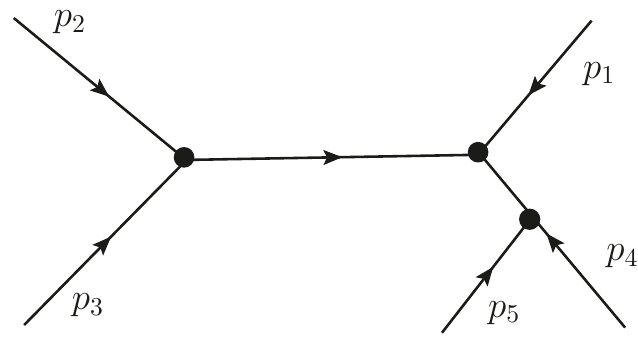
Figure 19. This diagram de(cid:12)nes K ( p 1 ; p 2 ; p 3 ; p 4 ; p 5 ) in